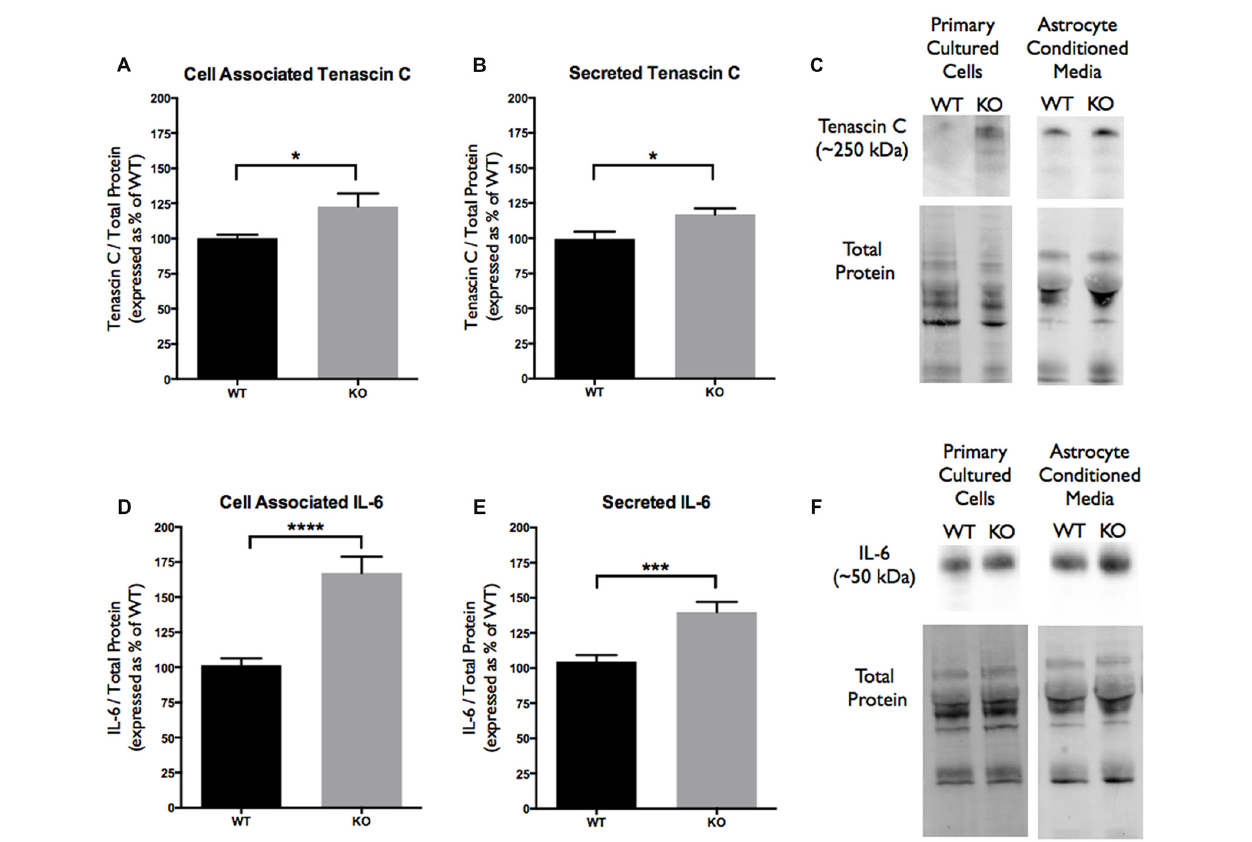
FIGURE 4 | Cell associated and secreted TNC and IL-6 expression is significantly enhanced in vitro by FMR1 KO astrocyte conditioned media (ACM). (A) Cell associated expression of TNC in WT (black; n = 6) and FMR1 KO (gray; n = 6) primary astrocyte cultured cells grown for 7 days in vitro . Representative bands were normalized to the total protein and expressed as a percentage of the average TNC in the WT group. Statistical differences denoted with a single asterisk, P < 0.05. (B) Secreted expression of TNC in WT (black; n = 6) and FMR1 KO (gray; n = 6) ACM. Representative bands were normalized to the total protein and expressed as a percentage of the average TNC in the WT group. Statistical differences denoted with a single asterisk, P < 0.05. (C) Western blots showing TNC expression ( ∼ 250 kDa) in primary astrocyte cultured cells and ACM. Corresponding total protein was used as a loading control. (D) Cell associated expression of IL-6 in WT (black; n = 6) and FMR1 KO (gray; n = 6) primary astrocyte cultured cells grown for 7 days in vitro . Representative bands were normalized to the total protein and expressed as a percentage of the average IL-6 in the WT group. Statistical differences denoted with four asterisks, P < 0.0001. (E) Secreted expression of IL-6 in WT (black; n = 6) and FMR1 KO (gray; n = 6) ACM. Representative bands were normalized to the total protein and expressed as a percentage of the average IL-6 in the WT group. Statistical differences denoted with a triple asterisk, P < 0.001. (F) Western blots showing IL-6 expression ( ∼ 50 kDa) in primary astrocyte cultured cells and ACM. Corresponding total protein was used as a loading